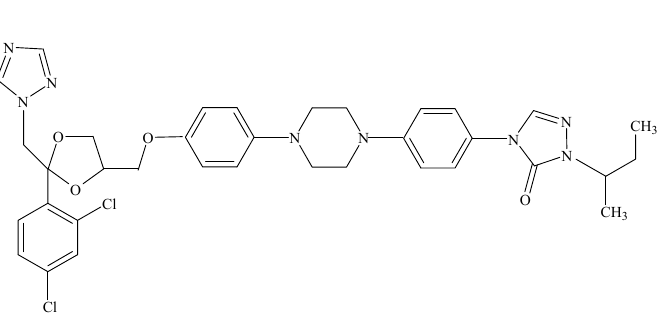
Figure 1. Structure of itraconazole.